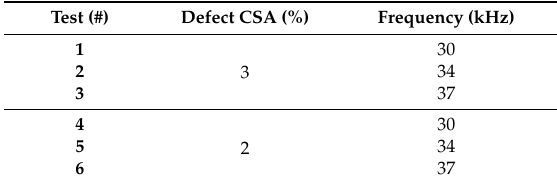
Table 1. Summary of the first set of tests conditions (first defect). CSA: cross-sectional area.